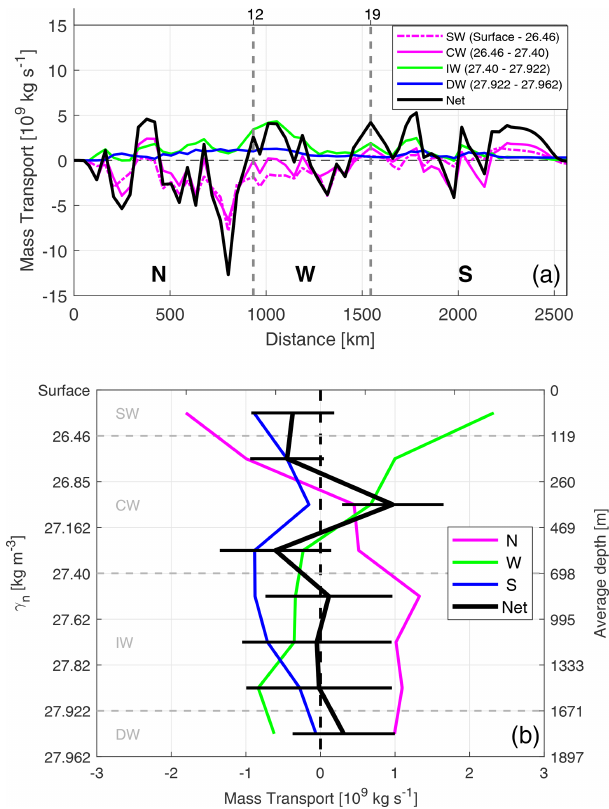
Figure 11. (a) Accumulated mass transports per SW, CW, IW and DW levels, and (b) mass transports integrated per north, west and south transect, estimated by the inverse model during the FLUXES- I cruise (including WOA stations in transects N and S). Negative (positive) values indicate inward (outward) transports in both plots. Mass conservation in the whole domain close to the coast is shown by the black line. The northwestern and southwestern corners are indicated by vertical dashed lines at stations 12 and 19 in the ac- cumulated mass transports (a) . The horizontal bars in each layer represented by the net mass transport are the errors estimated by the inverse model (b) .